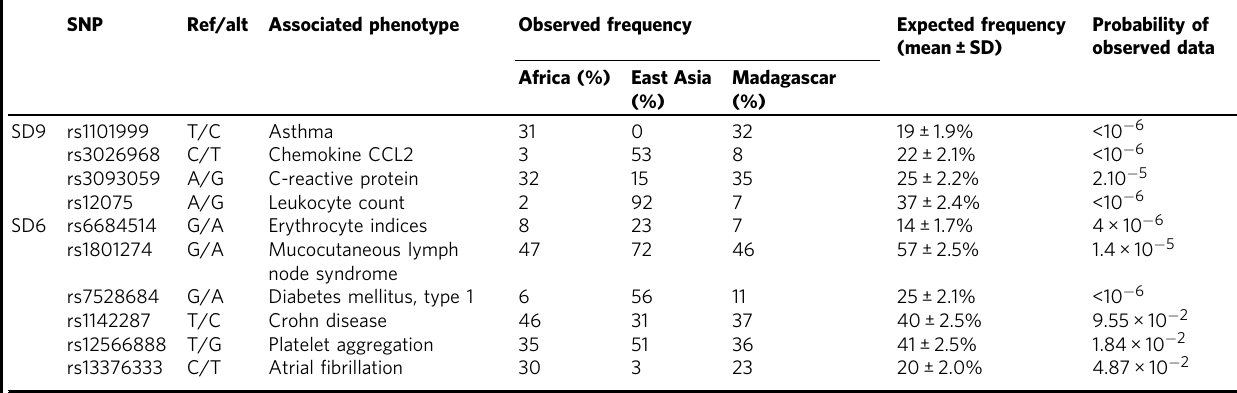
The frequency observed in Madagascar is compared with that observed in Africa and East Asia, and to the expected frequency produced by admixture without selection (based on one million computer simulations 15 ). Probability of observed data is based on the quantile of the observed frequency in the distribution of the simulation